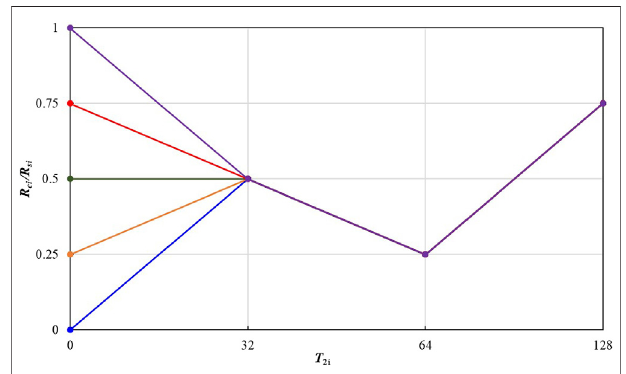
FIGURE 3 | The C d path composed of C d values and the order number of T 2